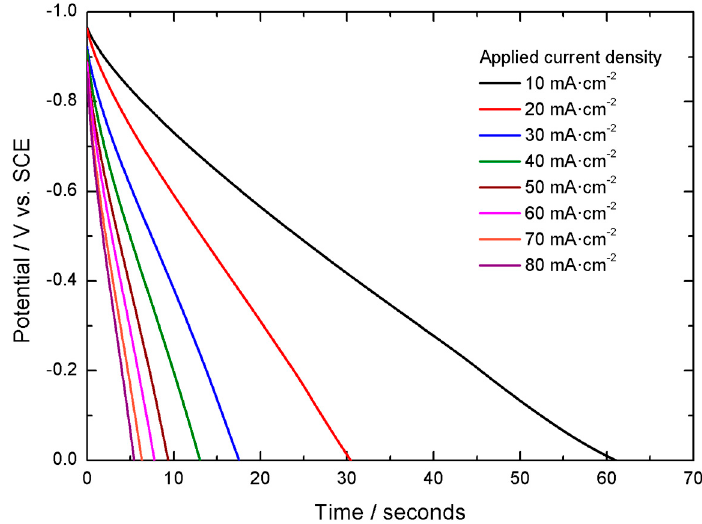
Figure 9. Galvanostatic discharge curves for YEC-8A in KOH 6M at different current densities.